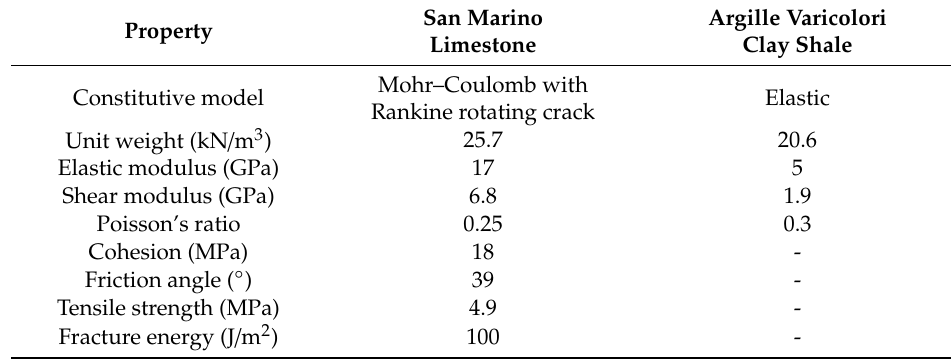
Table 3. Intact material properties assumed for the FDEM numerical modelling of the 2014 San Leo landslide in